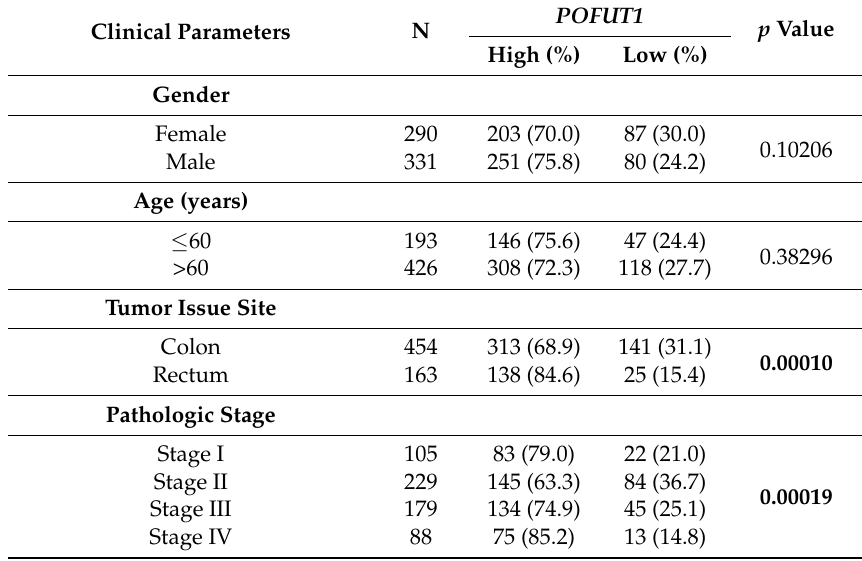
Table 1. Correlation between POFUT1 expression and clinical parameters in patients with